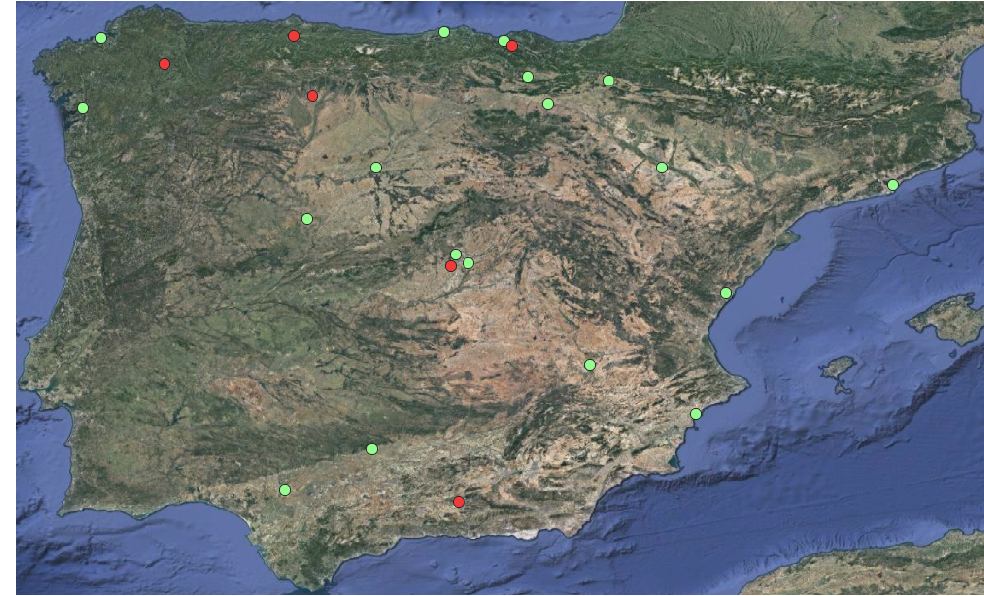
Figure 6. Geographical distribution of the dataset (green training set/red testing